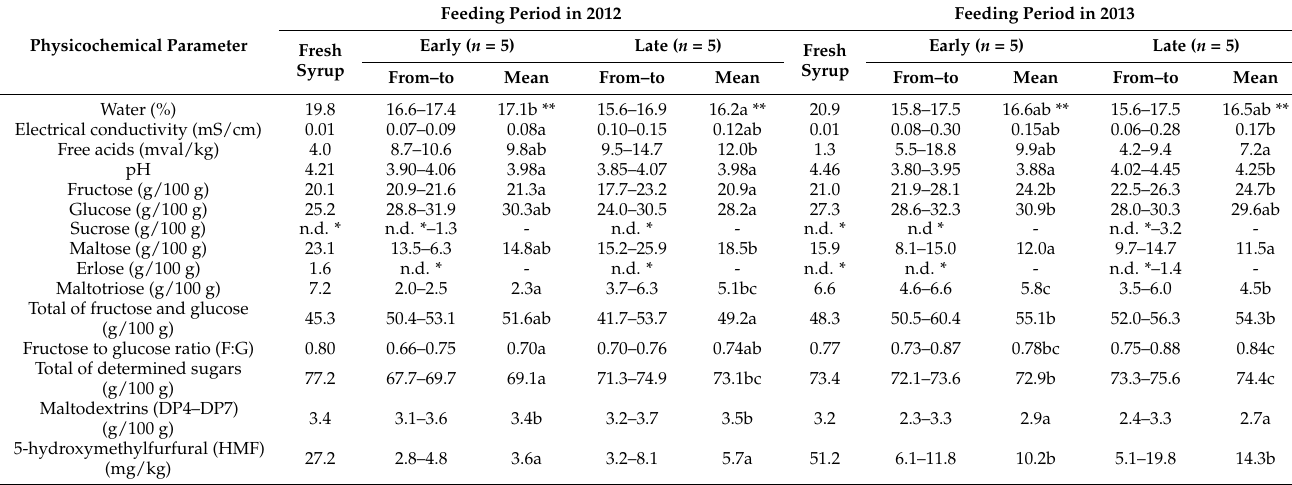
Table 3. Physicochemical composition of winter stores produced by bees fed with starch syrup III (Apifood).